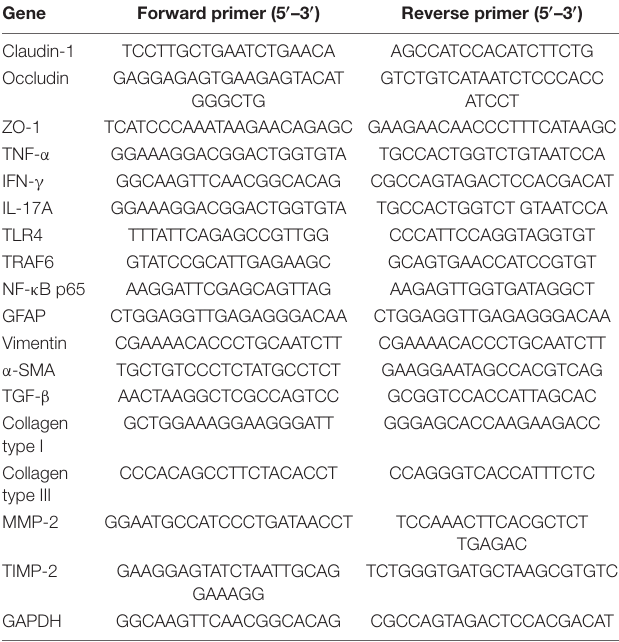
TABLE 1 | Primer sequence for qRT-PCR. Gene Forward primer (5 (cid:48) –3 (cid:48) ) Reverse primer (5 (cid:48) –3 (cid:48)